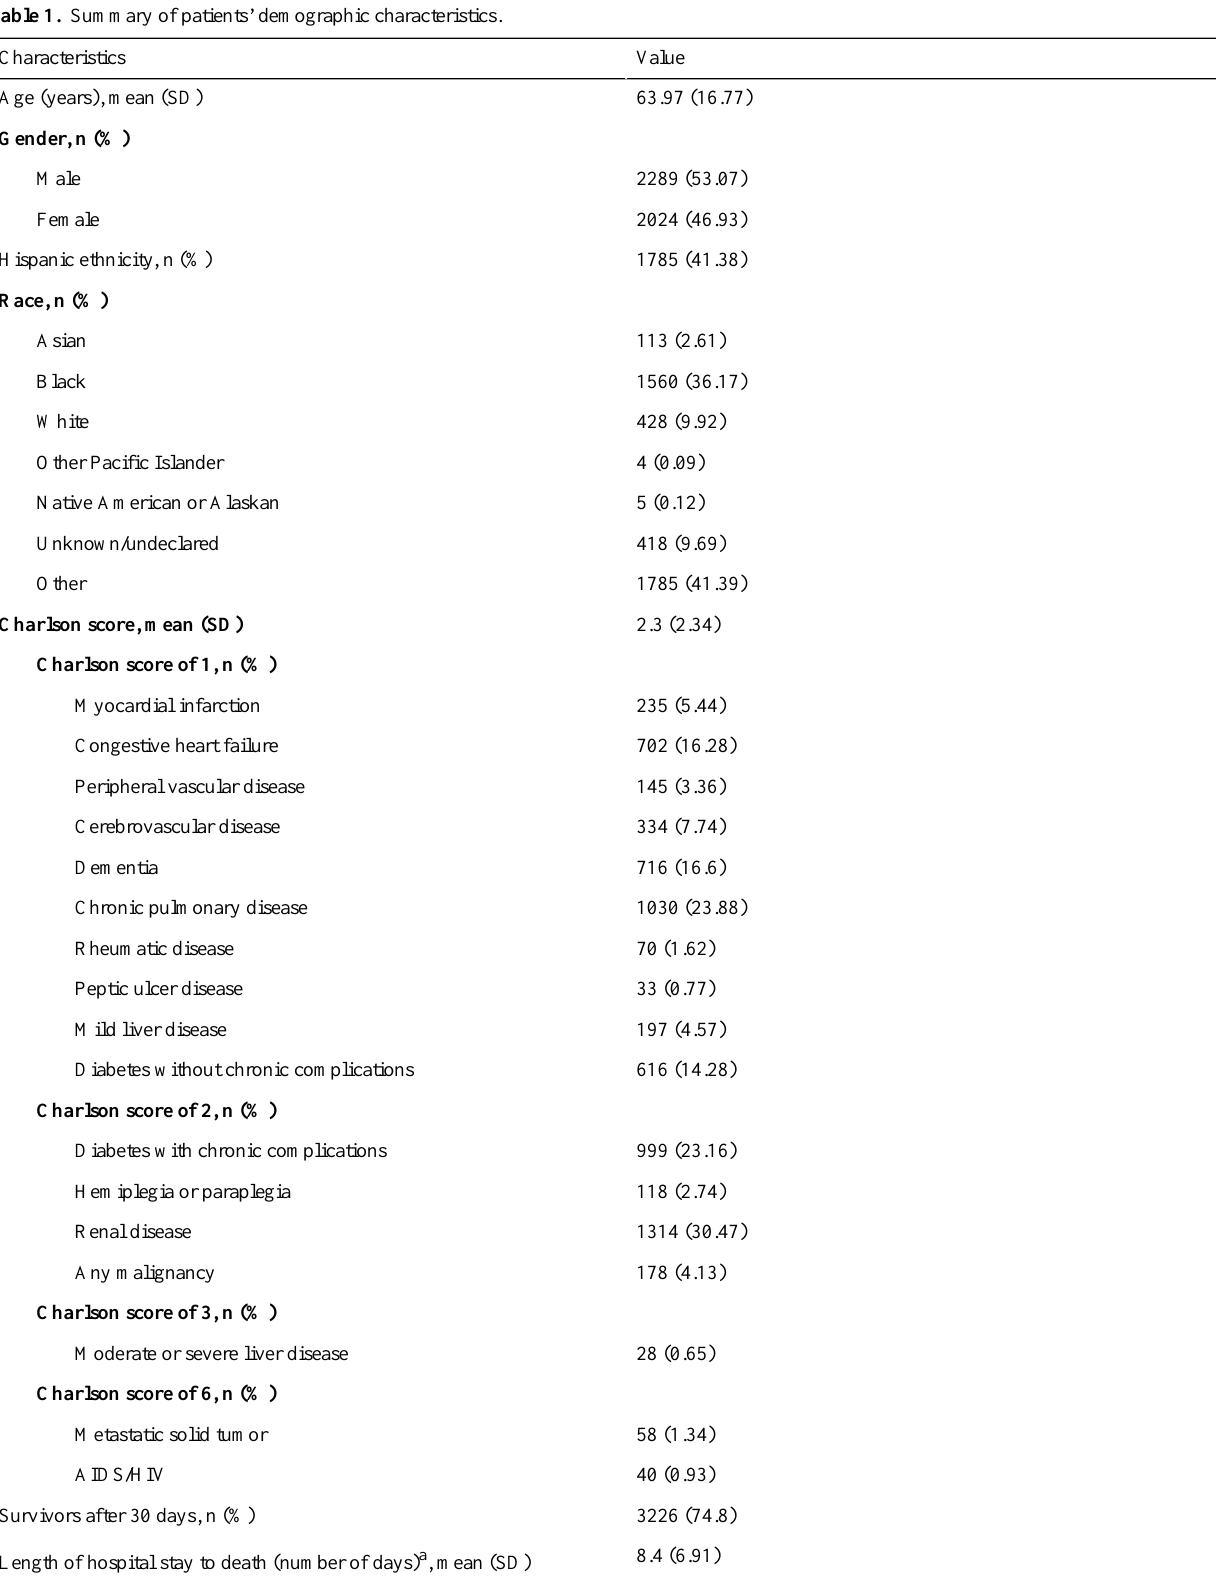
Table 1. Summary of patients’demographic